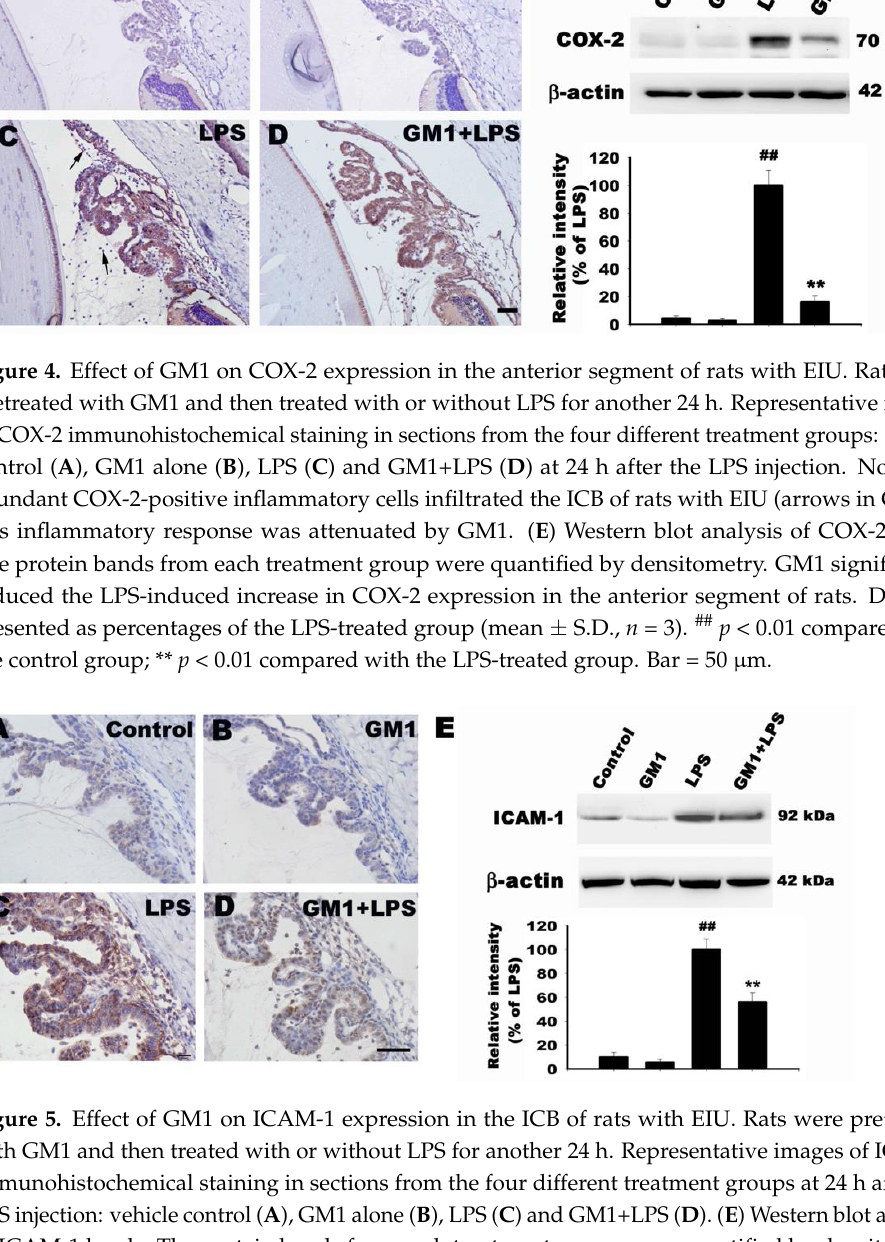
Figure 4. Effect of GM1 on COX-2 expression in the anterior segment of rats with EIU. Rats were pretreated with GM1 and then treated with or without LPS for another 24 hours. Representative images of COX-2 immunohistochemical staining in sections from the four different treatment groups: vehicle control ( A ), GM1 alone ( B ), LPS ( C ) and GM1+LPS ( D ) at 24 h after the LPS injection. Note that abundant COX-2-positive inflammatory cells infiltrated the ICB of rats with EIU (arrows in C), and this inflammatory response was attenuated by GM1. ( E ) Western blot analysis of COX-2 levels. The protein bands from each treatment group were quantified by densitometry. GM1 signif- icantly reduced the LPS-induced increase in COX-2 expression in the anterior segment of rats. Data are presented as percentages of the LPS-treated group (mean ± S.D., n = 3). ## p < 0.01 compared with the control group; ** p < 0.01 compared with the LPS-treated group. Bar = 50  m.